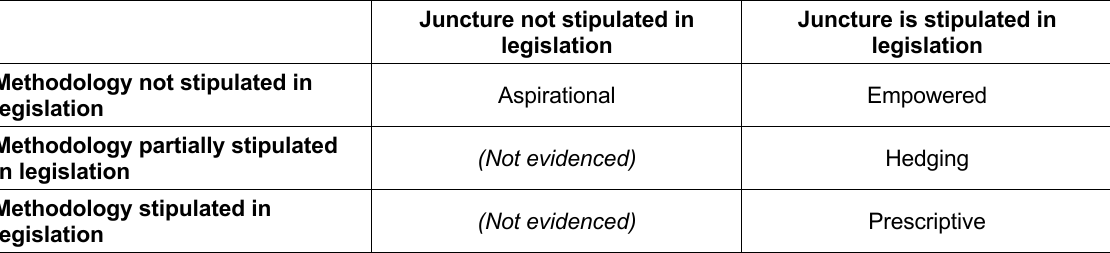
Table 1: Typology of approaches to community engagement legislation by Australian states and